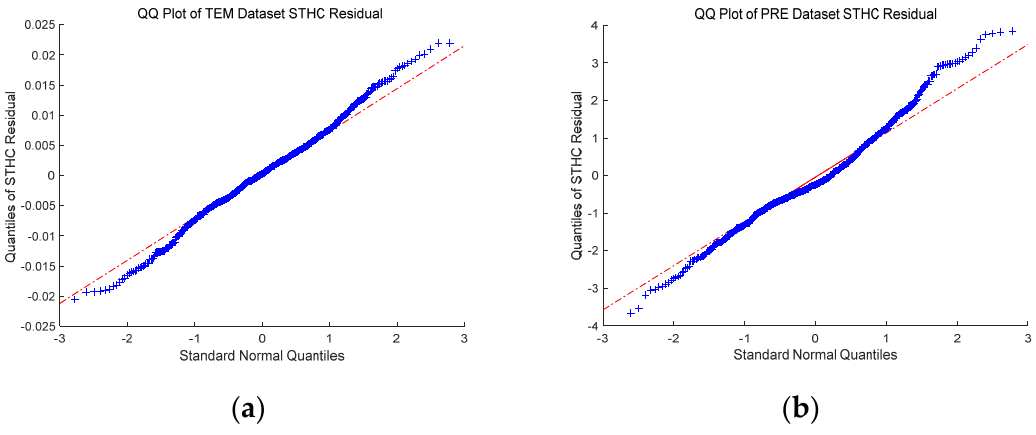
Figure 9. Quantile ‐ Quantile plot of the residuals obtained by the STHC method; ( a ) temperature data (kurtosis = 3.06, skewness = 0.01); and ( b ) precipitation data (kurtosis = 3.40, skewness = 0.33).